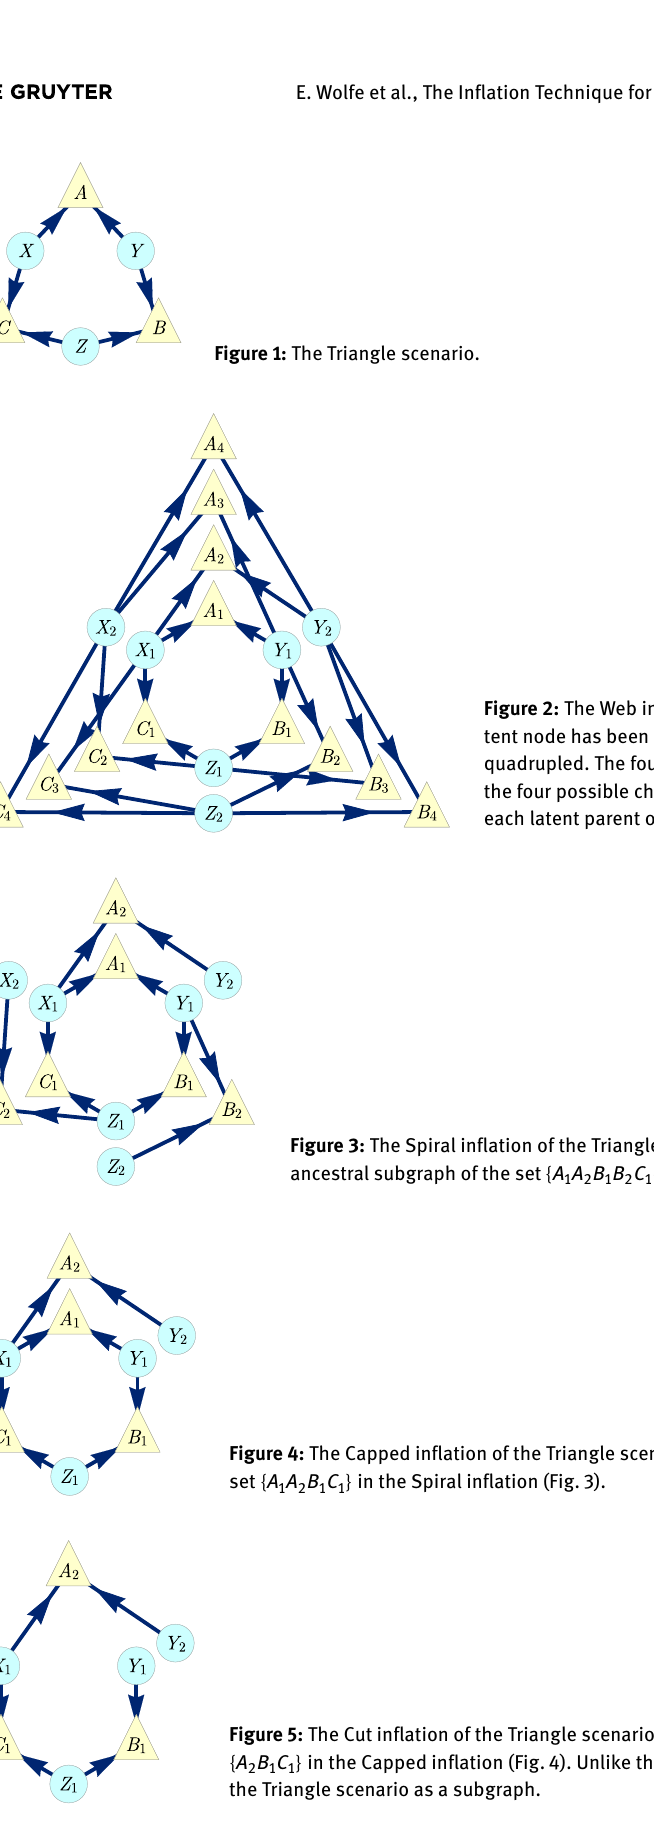
Figure 5: The Cut inflation of the Triangle scenario; notably also the ancestral subgraph of the set { A 2 B 1 C 1 } in the Capped inflation (Fig.4). Unlike the other examples, this inflation does not contain the Triangle scenario as a